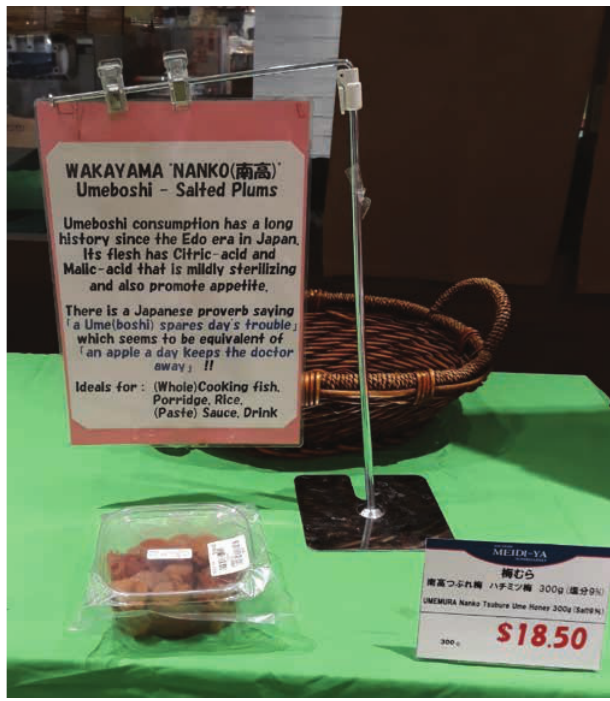
Figure 10: Wakayama Nanko Umeboshi - Salted Plums: historical and nutritious A common Japanese condiment, salted plums ( umeboshi ) are symbolic of traditional Japanese cuisine; in